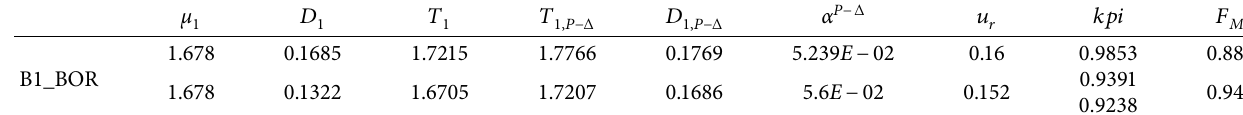
Table 14: Design summary of building B1 under BORREGO